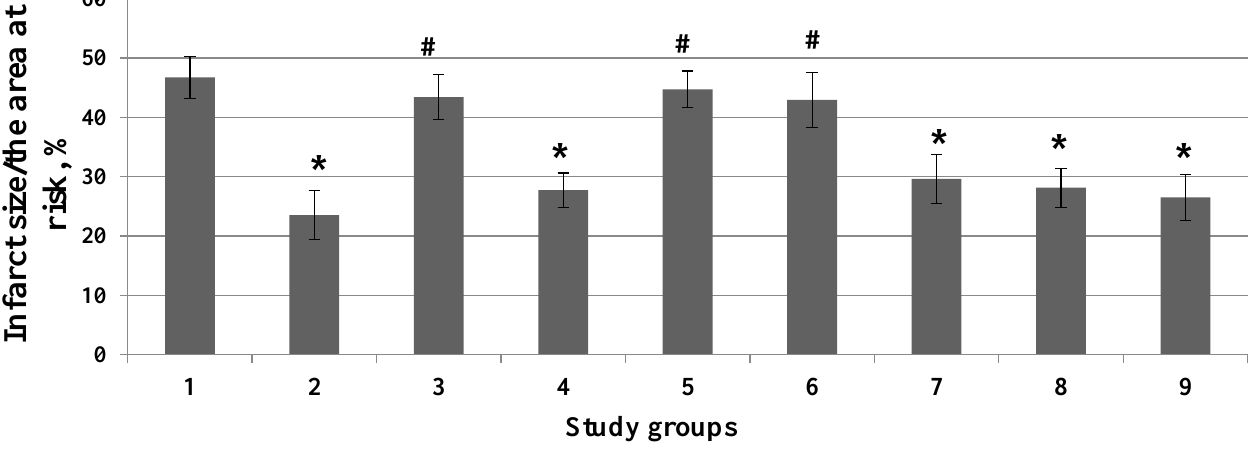
Figure 4. The involvement of K ATP channels, MPT pore, the BK Ca channel, and ROS in the infarct-reducing effect of deltorphin II ( Y -axis). 1—Control; 2—Deltorphin II; 3—Deltorphin II + Glibenclamide; 4—Deltorphin II + 5-HD; 5—Deltorphin II + HMR1098; 6—Deltorphin II + Atractyloside; 7—Deltorphin II + Paxilline; 8—Deltorphin II + MPG; 9—Deltorphin II + Tempol. Data represent the means ± SEM. * p < 0.05 vs. the control group; # p < 0.05 vs. the deltorphin II group. Each study group included 12 rats.